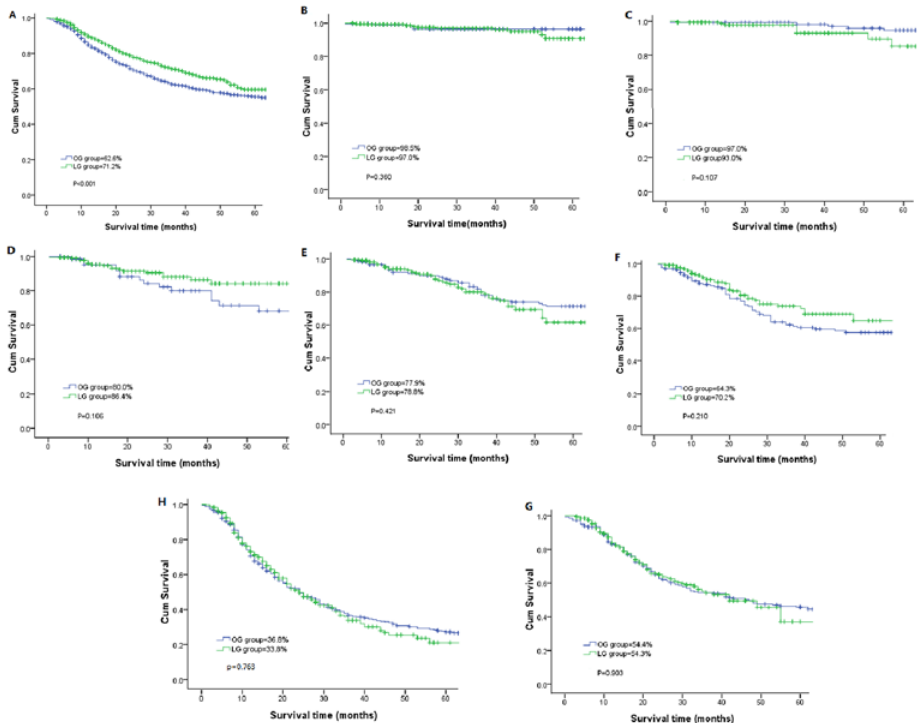
Figure 2. Kaplan-Meier curves for OS. Kaplan-Meier curves for OS between the laparoscopic gastrectomy and open gastrectomy groups.